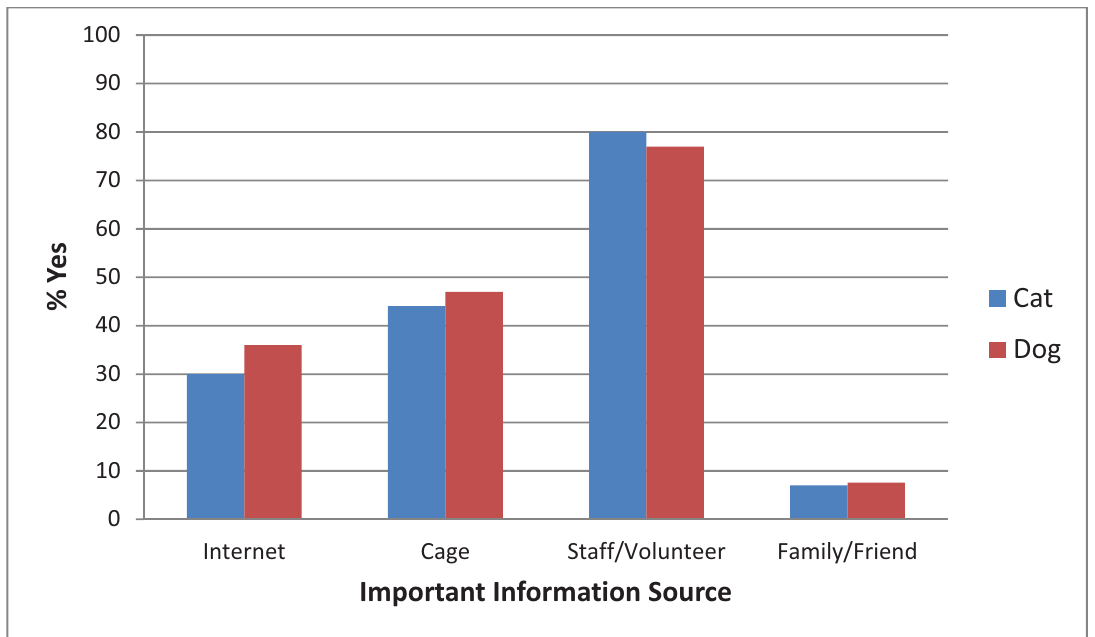
Figure 7. Adopter’s responses when asked which source provided the most important information about their dog or cat.